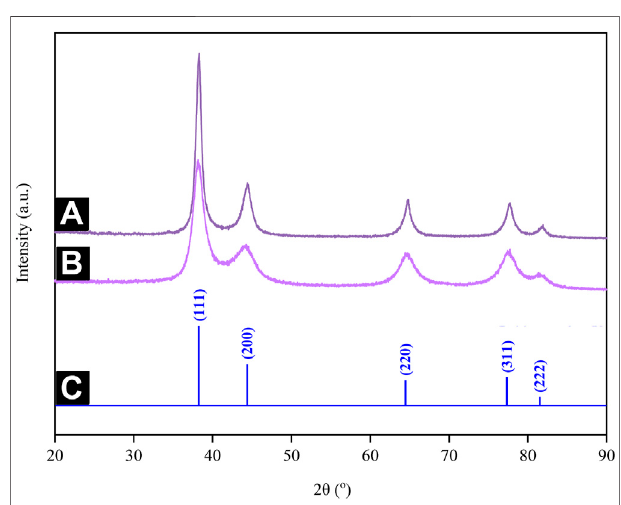
FIGURE 11 | XRD patterns of (A) AuNPs@pH6 and (B) AuNPs@pH10 along with the (C) stick patterns for the JCPDS fi le no. 04-0,784.